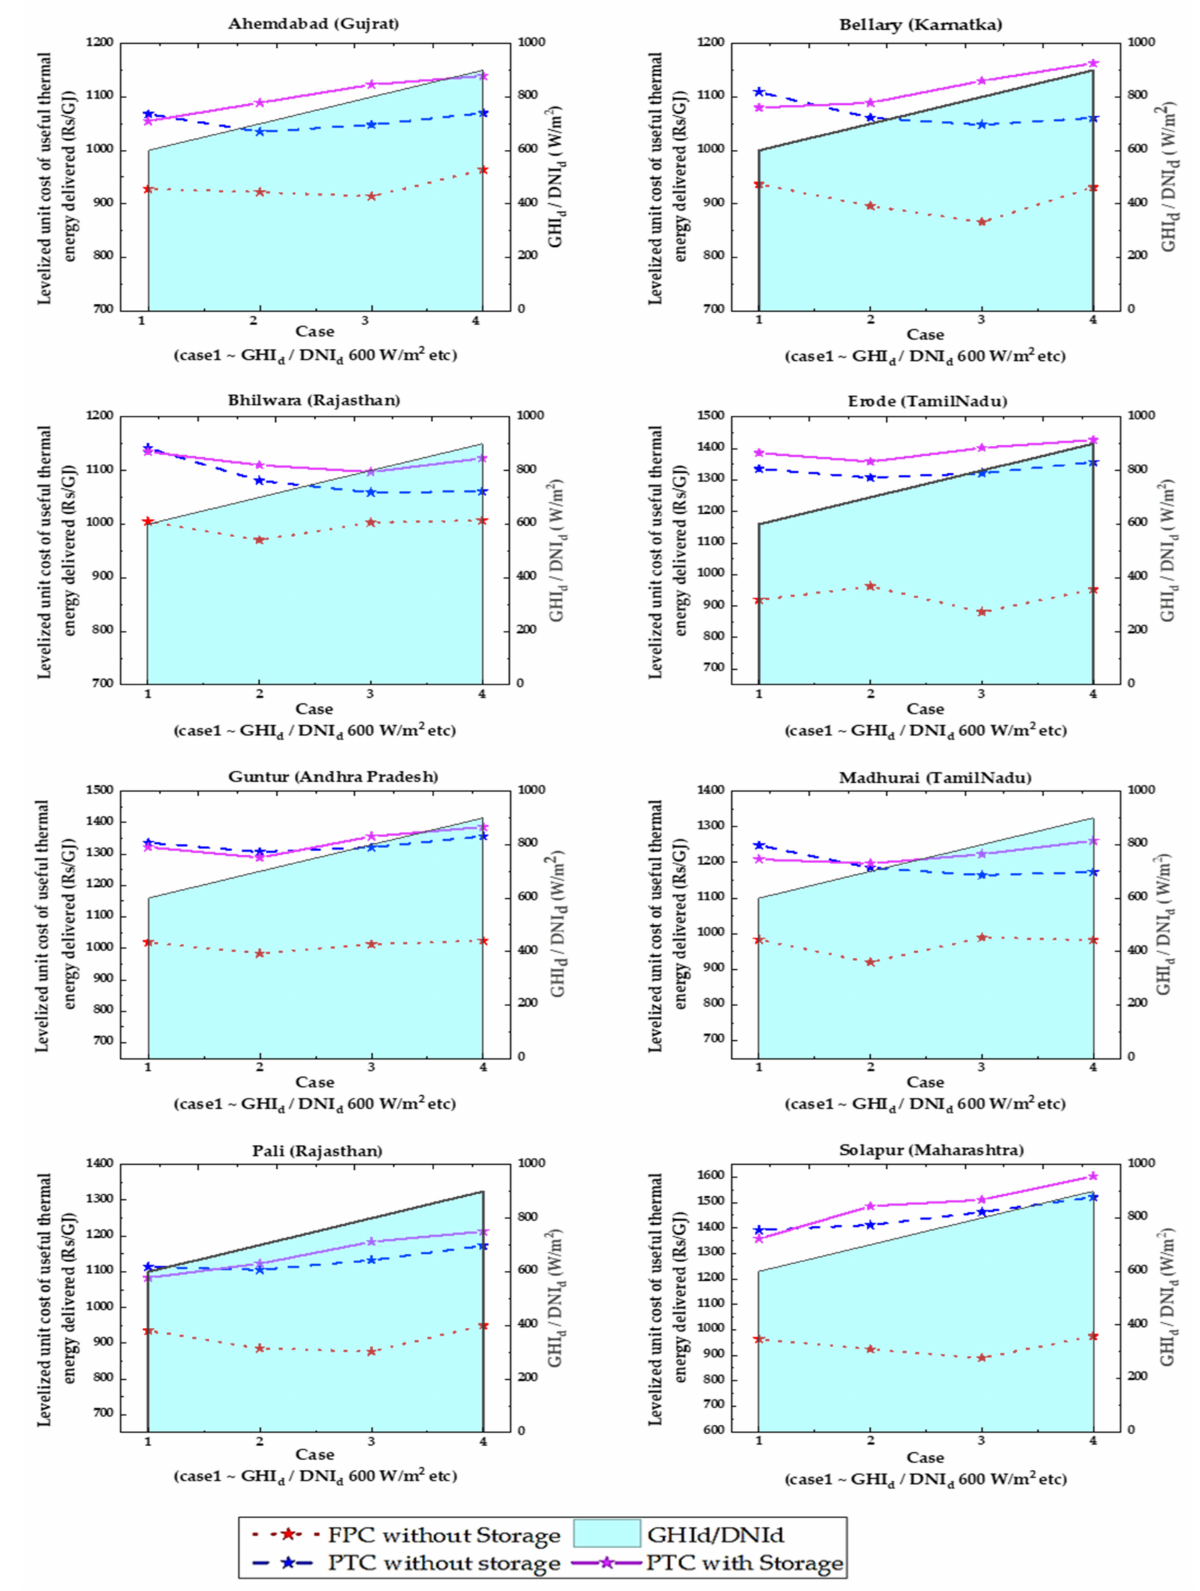
Figure 5. Calculated cost of deliverable thermal energy under various